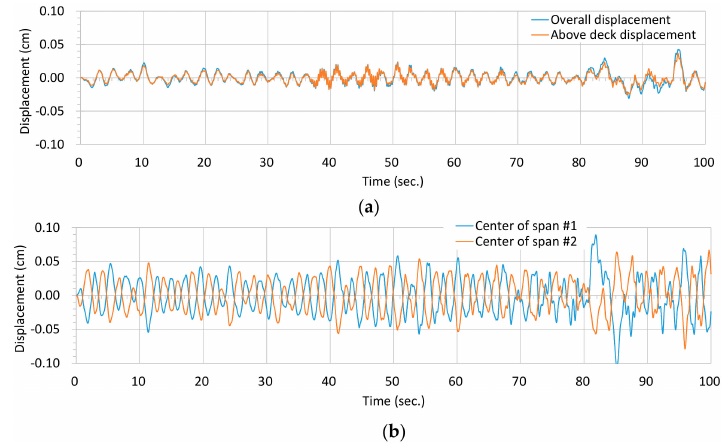
Figure 9. Displacement time histories. ( a ) Relative displacement of the pylon (longitudinal direction). ( b ) Vertical displacement of the center of the span.